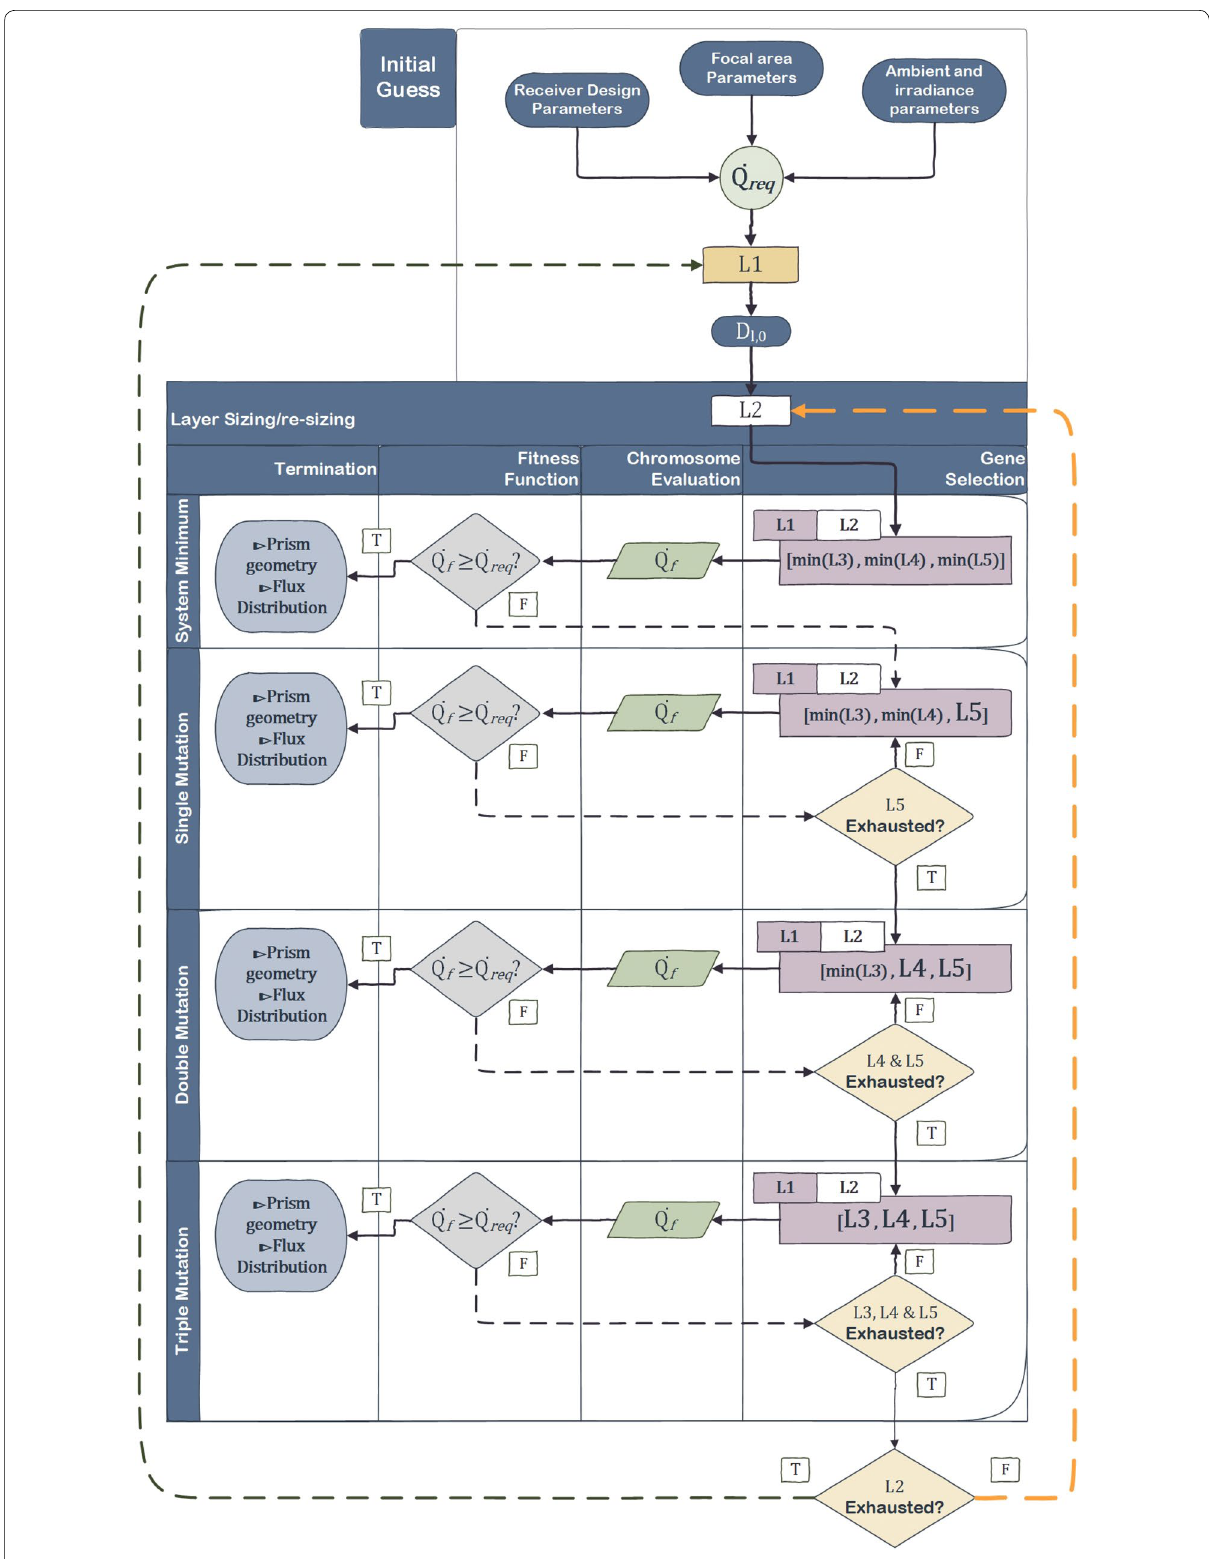
Fig. 2 Flow-chart of the